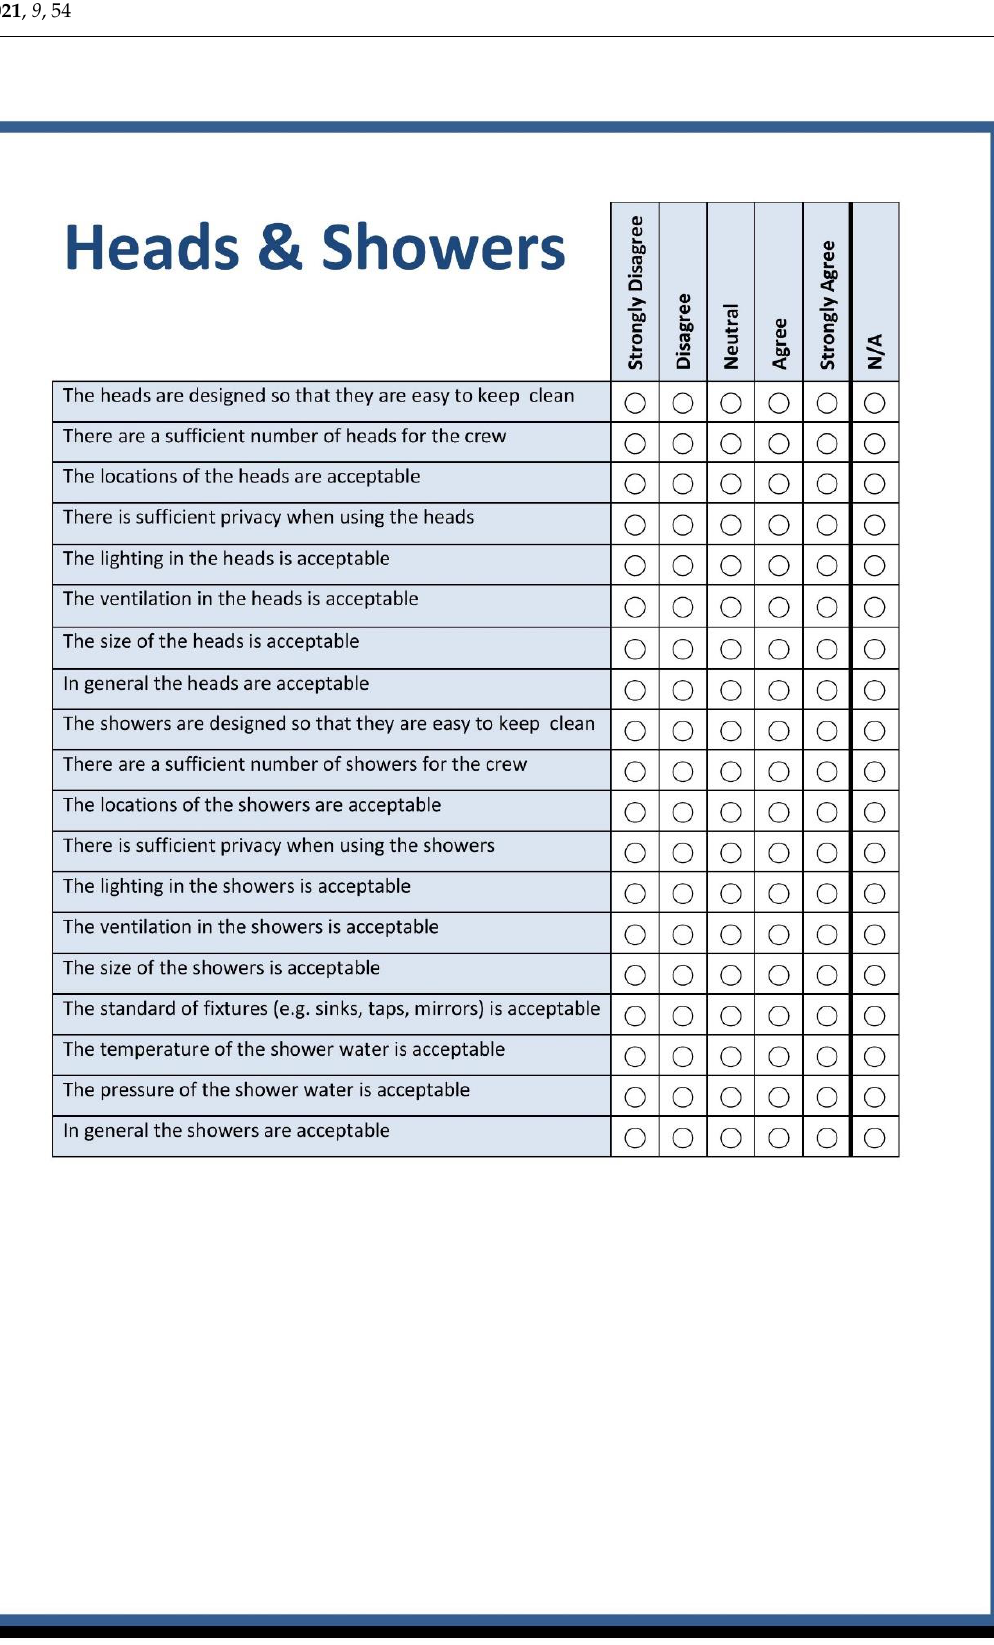
Figure A10. The Submarine Habitability Assessment Questionnaire (continued).